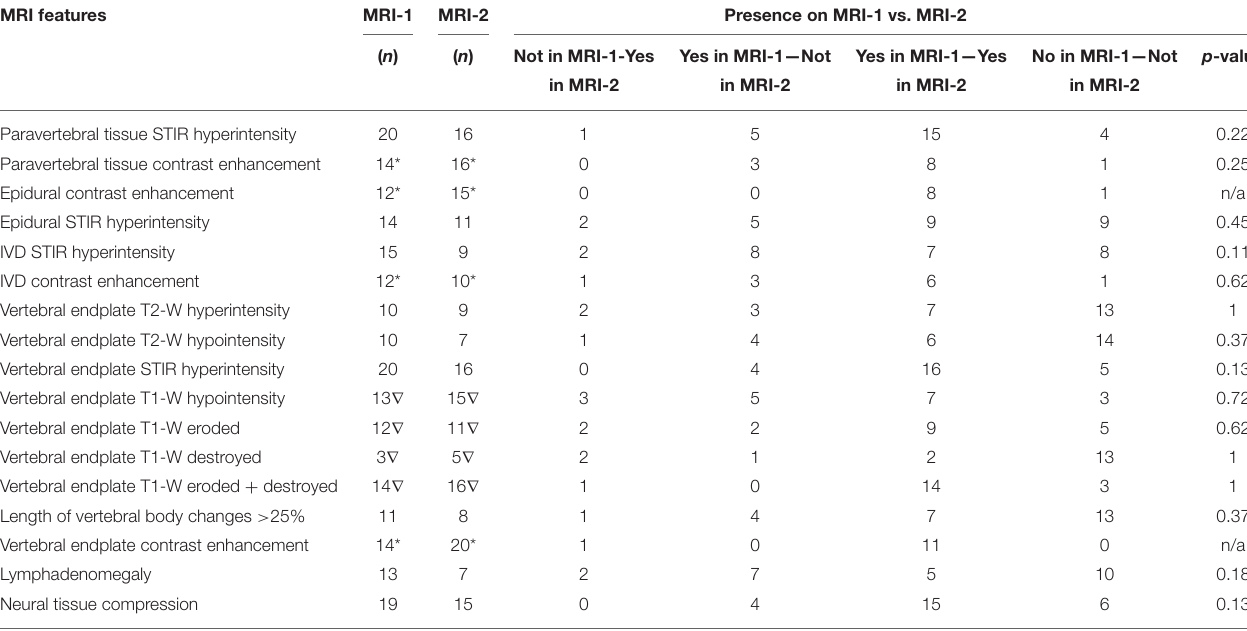
TABLE 3 | Magnetic resonance imaging (MRI) features detected on initial presentation (MRI-1) and follow-up (MRI-2) in 25 dogs with discospondylitis. MRI